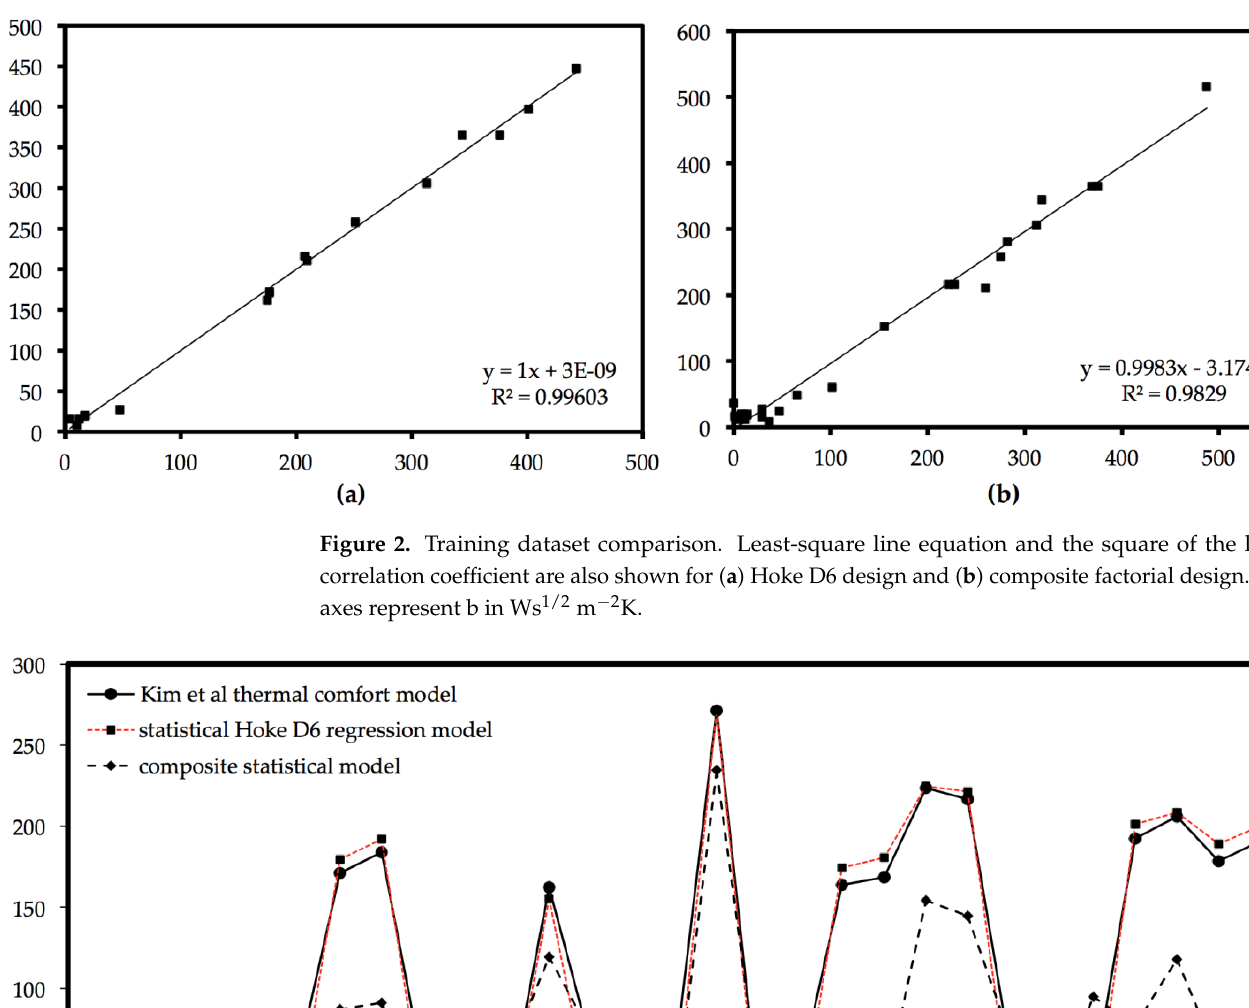
Figure 1. Test dataset comparison. Both DOE methods provided models with satisfactory data trends and good fit to absolute location for the test datasets. ( a ) Outputs of Hoke D6 design model compared to those of Kim et al. ’s model [28]; ( b ) outputs of composite factorial regression model compared to those of Kim et al. ’s model [28]. y axis — b in Ws 1/2 m −2 K; x axis — the number of the tested scenario.